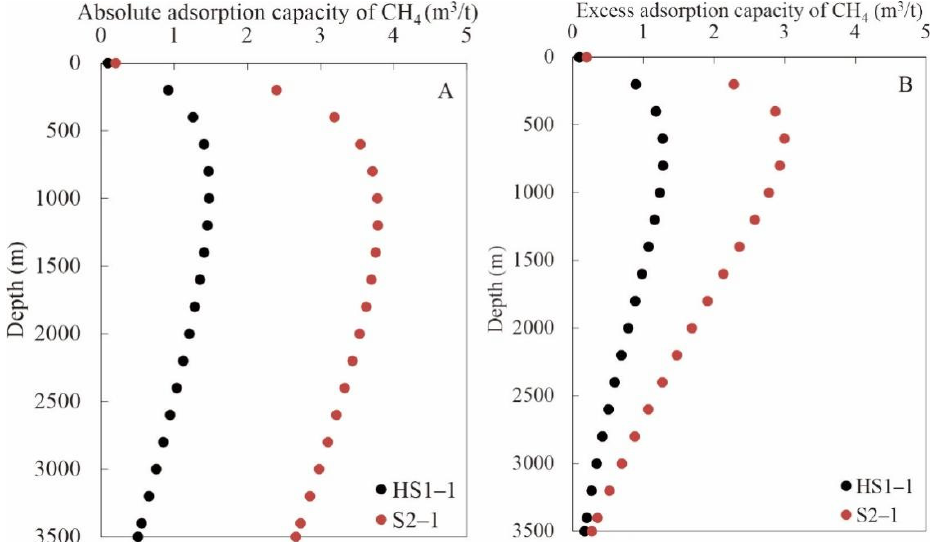
Figure 7. Profiles of absolute adsorption capacity of CH 4 ( A ) and excess adsorption capacity of CH 4 ( B ) with depth based on Langmuir adsorption models.